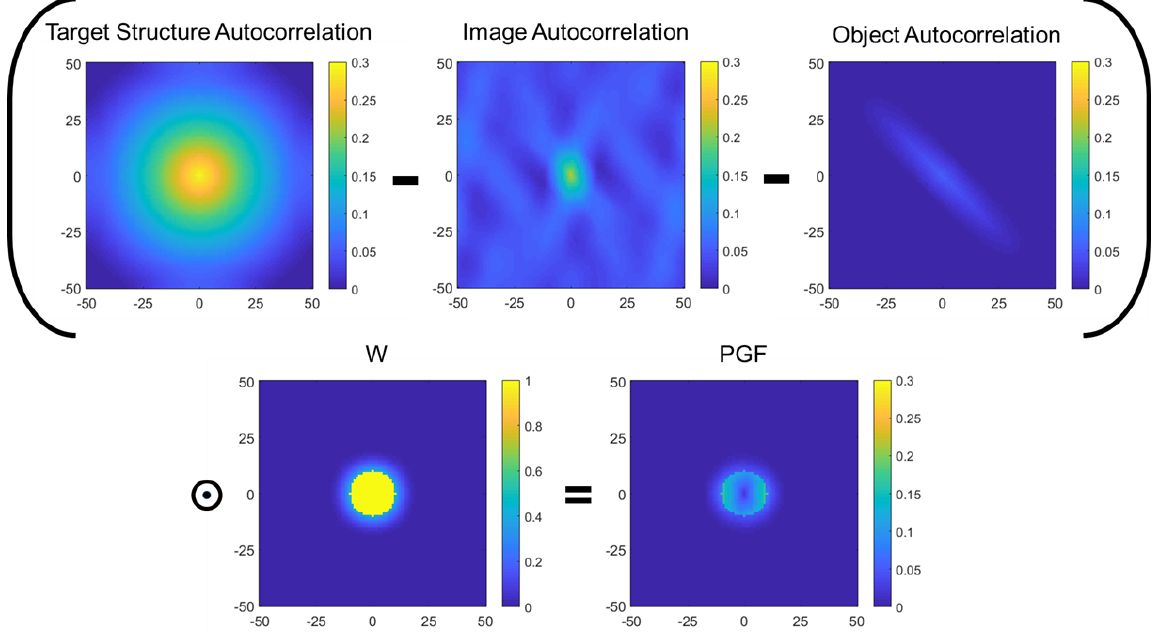
Figure 8. Graphical depiction of the operations involved in the calculation of the PFG (see Equation (7)).